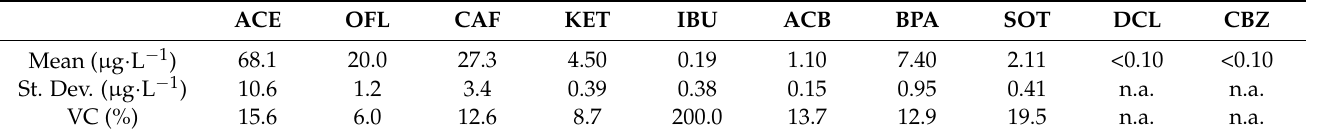
Table 4. Concentration of several EPs in the influent to the combined HD–VF–PD